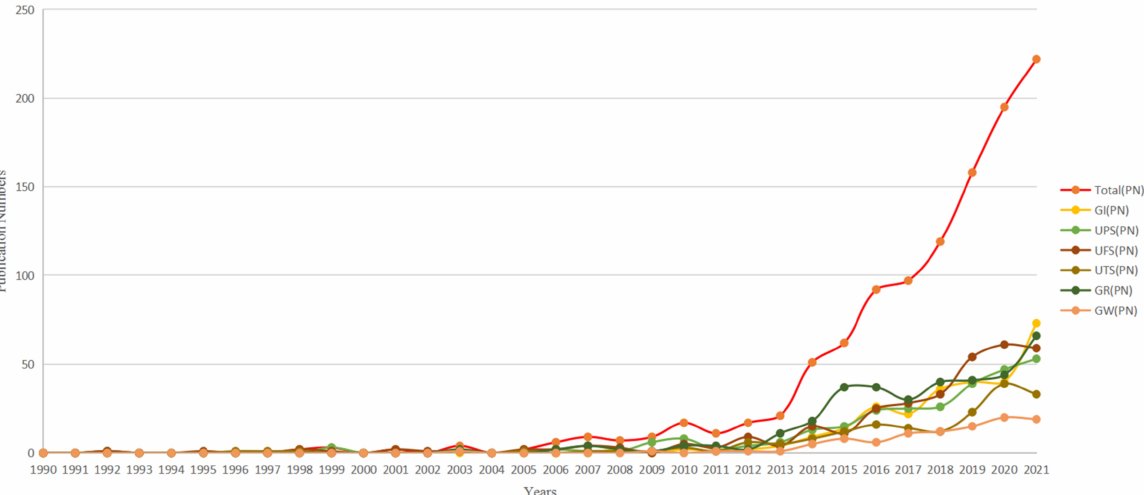
Figure 2. Line chart of publication trend from 1990 to 2021 (number of publications per year). (PN), publication numbers; Total (PN), the publications numbers of all GI